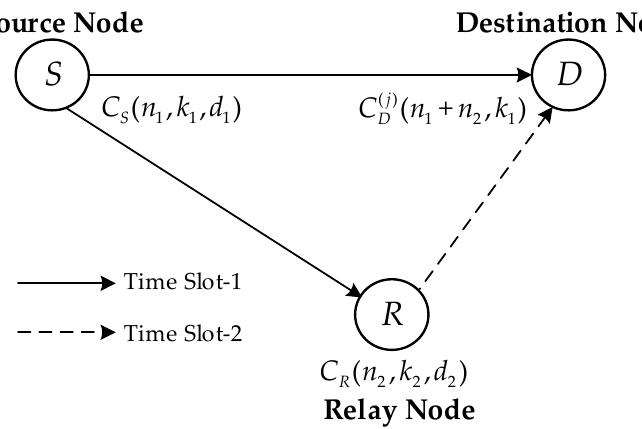
Figure 1. Generalized distributed linear block coding scheme.